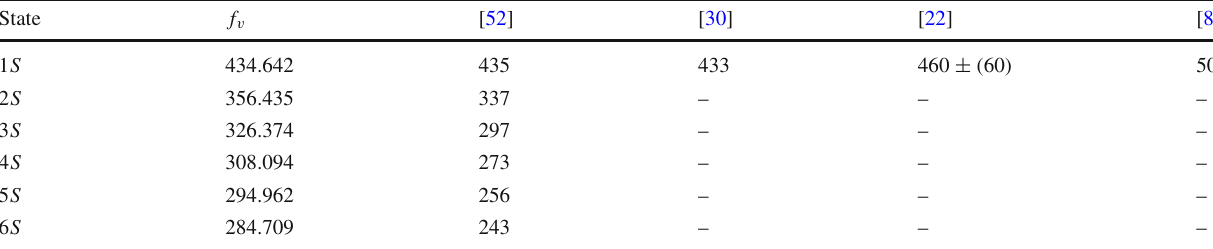
Table 13 Vector decay constant of B c meson (in MeV)